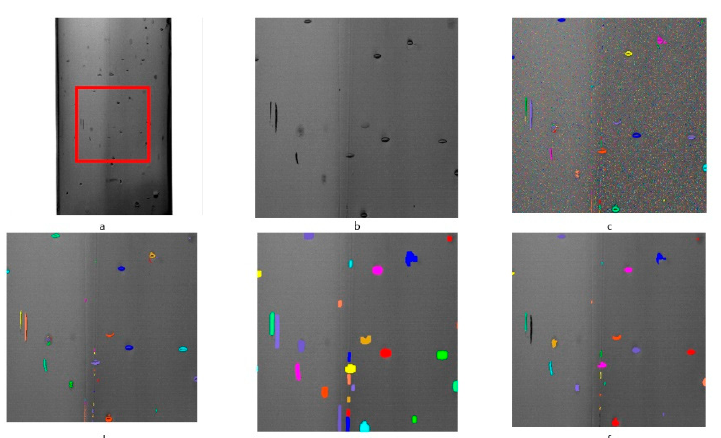
Figure 5. The sequence of the processing algorithm for the candidate selection: ( a ) input image of the bottle; ( b ) region of the bottle zoomed in for better understanding; ( c ) local threshold is applied; ( d ) tblobs after filtering by size and shape; ( e ) connected regions after dilation operation; ( f ) final blobs named as “candidates” for next